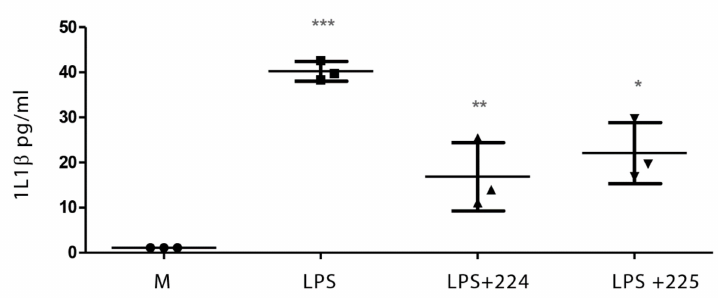
Figure 2. E ff ect of UK propolis (50 µ g / mL) on interleukin-1 β (IL-1 β ) production by LPS-stimulated macrophages; n = 3 * p value < 0.05, ** p value < 0.01, and *** p value < 0.001. Comparisons of LPS against medium and LPS + propolis samples 224 and 225 against LPS. Medium alone = M.